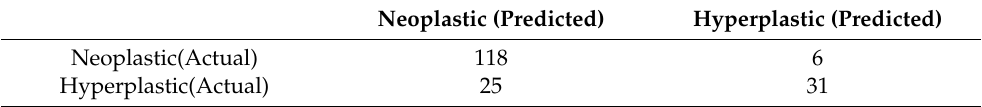
Table 18. Confusion matrix of NBI polyp classification.